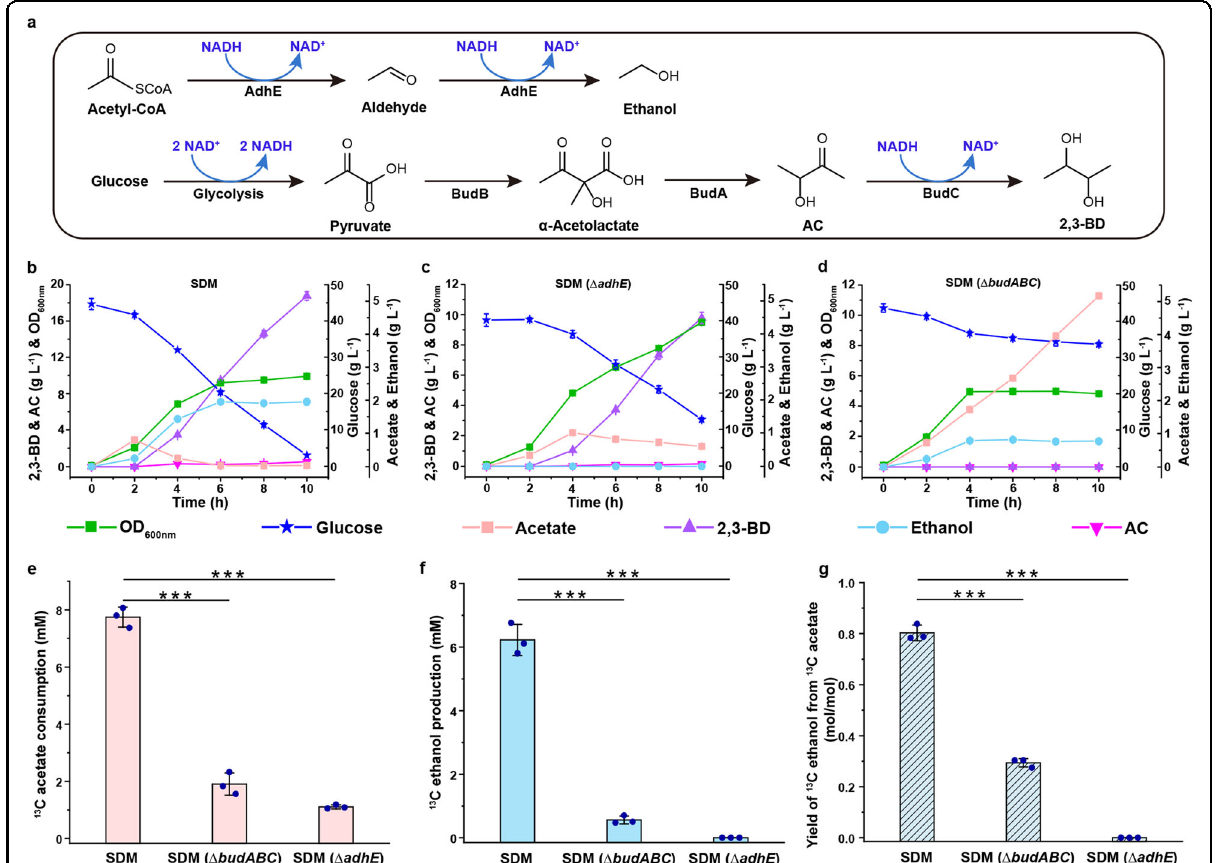
Fig. 1 2,3-BD biosynthesis and ethanol production participate in the elimination of acetate produced by over fl ow metabolism. a Reactions related to ethanol production and 2,3-BD biosynthesis in E. cloacae SDM. AdhE, bifunctional acetaldehyde/ethanol dehydrogenase; BudB, α - acetolactate synthase; BudA, α -acetolactate decarboxylase; BudC, 2,3-butanediol dehydrogenase; AC, acetoin; 2,3-BD, 2,3-butanediol. b Growth of E. cloacae SDM using glucose as carbon source. c Growth of E. cloacae SDM ( Δ adhE ) using glucose as carbon source. d Growth of E. cloacae SDM ( Δ budABC ) using glucose as carbon source. e Consumption of exogenous added 13 C acetate by E. cloacae SDM and its derivatives. f Production of 13 C ethanol by E. cloacae SDM and its derivatives. g Yield of 13 C ethanol from 13 C acetate by E. cloacae SDM and its derivatives. 13 C sodium acetate at a concentration about 10 mM was added into the culture system of E. cloacae SDM, E. cloacae SDM ( Δ adhE ), and E. cloacae SDM ( Δ budABC ) at 2 h. After 4 h of culture, the concentrations of 13 C ethanol and 13 C acetate were assayed. Experiments were carried out under aerobic conditions. Data shown are means ± SD ( n = 3 independent experiments). *** P < 0.001 in two-tailed Student ’ s t